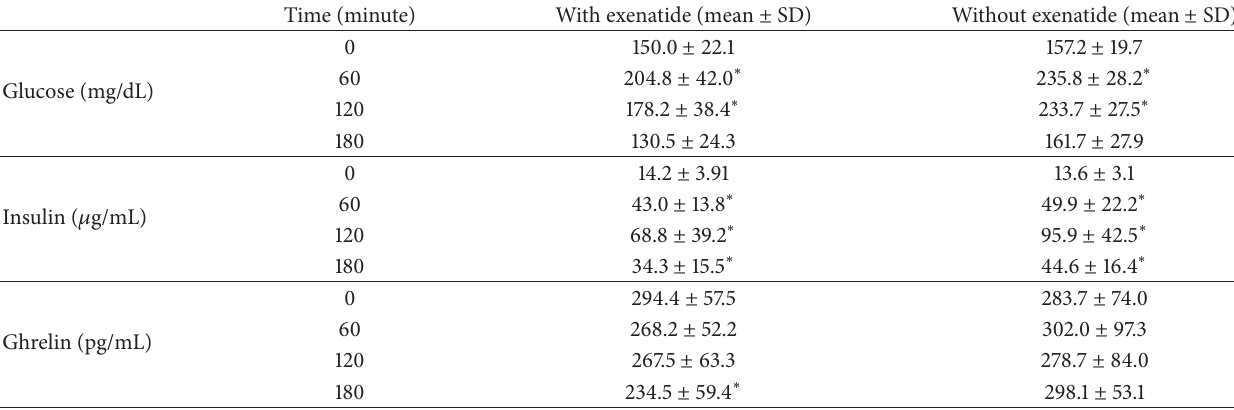
Table 2: Serum glucose, insulin, and ghrelin levels before (0 minutes) and at 60, 120, and 180 minutes following mixed meal test with and without exenatide usage.